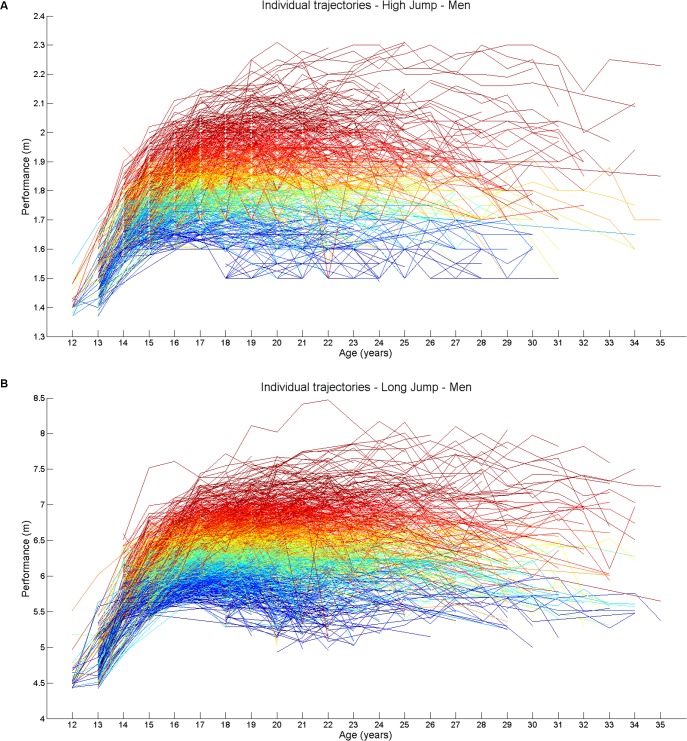
Individual performance trajectories in males (A) high jump and (B) long jump athletes. The individual trajectories are reported for each athlete with color varying according to personal best performance, from blue (lowest level athletes) to red (highest level athlete).